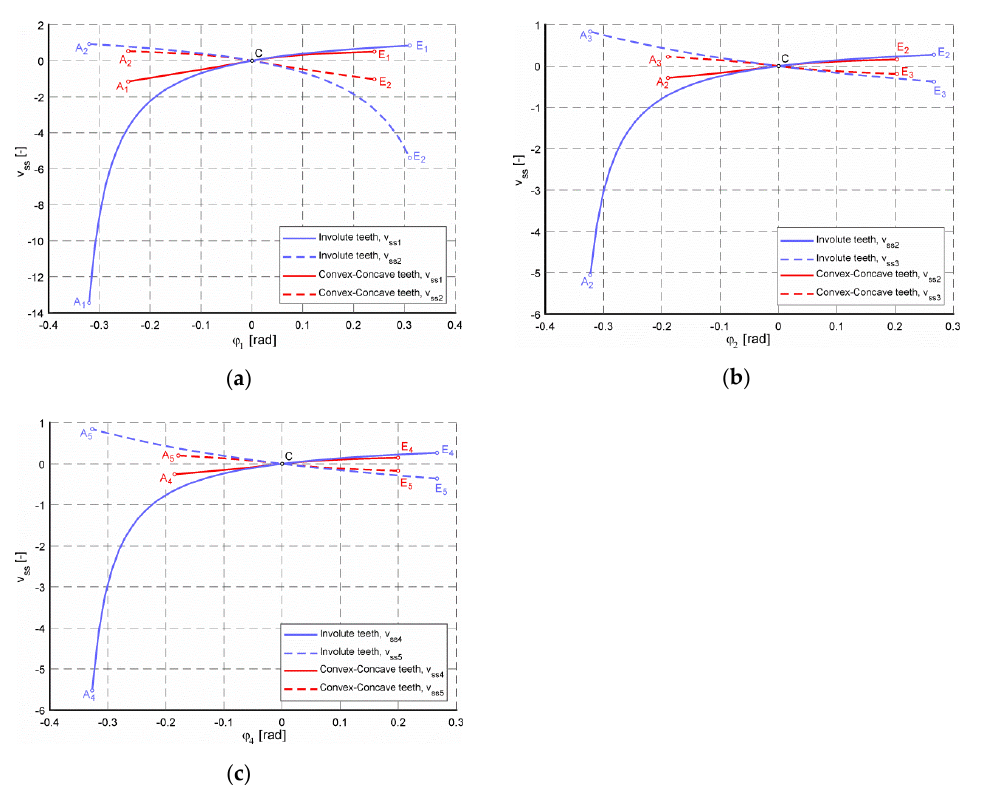
Figure 9. Specific sliding ratio v ss that depends on the angle ϕ pinion between the gear pairs with involute and convex–concave teeth flanks: ( a ) gear pair 1-2, ( b ) gear pair 2-3, and ( c ) gear pair 4-5.